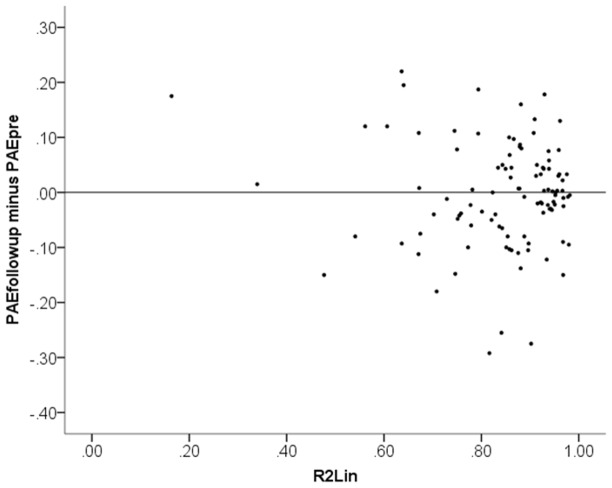
Scatter plot of change in performance from the first session to follow-up (PAEfollowup−PAEpre) plotted against linearity of numerical magnitude representation (R
2
Lin).